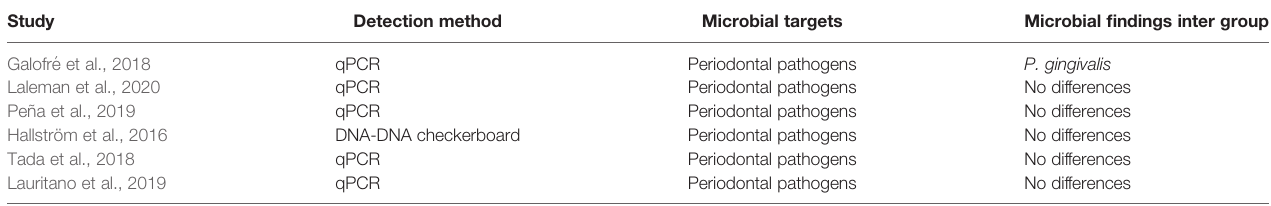
TABLE 3 | Quantitative synthesis of the microbiological outcome of the included